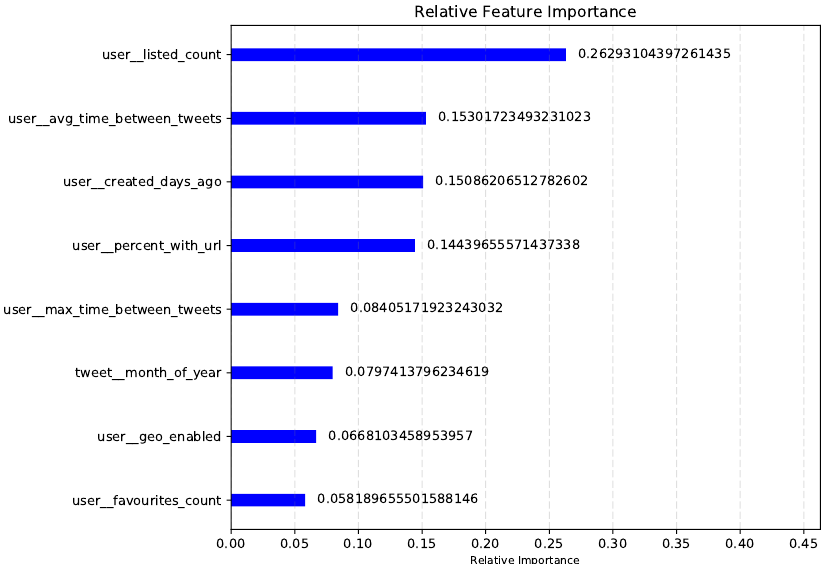
Figure 9. Feature importance for Scenario 2 (tweet and user level features), as computed by